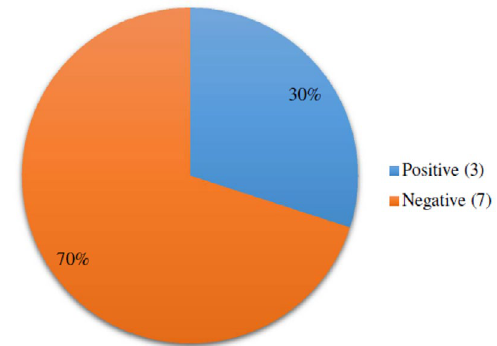
Fig. 3. Percentage of carbapenemase producers by mCIM